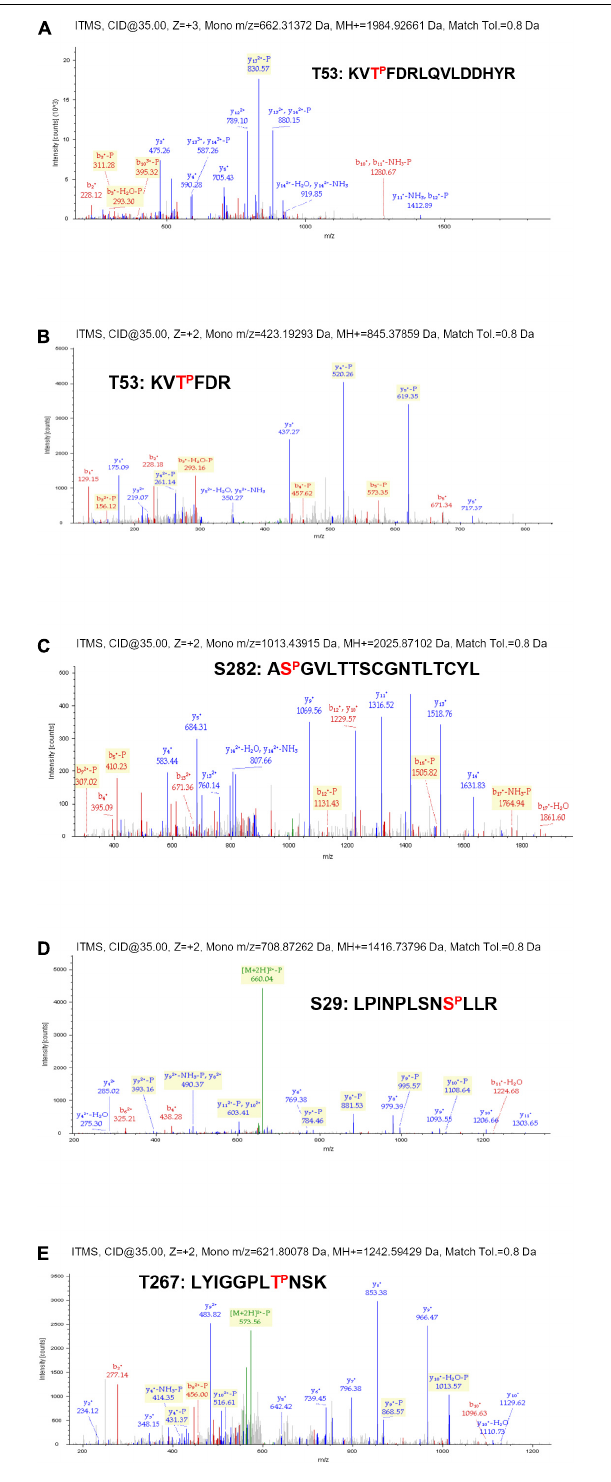
FIGURE 2 | Phosphoproteomic details from the phosphorylation experiment described in Figure 1 . MS/MS profiles for NS5B-FP tryptic peptides encompassing residues T53 (A,B) , S282 (C) , S29 (D) , and T267 (E) . Peptide sequences corresponding to each spectrum are indicated with the identified phosphorylated residue marked in